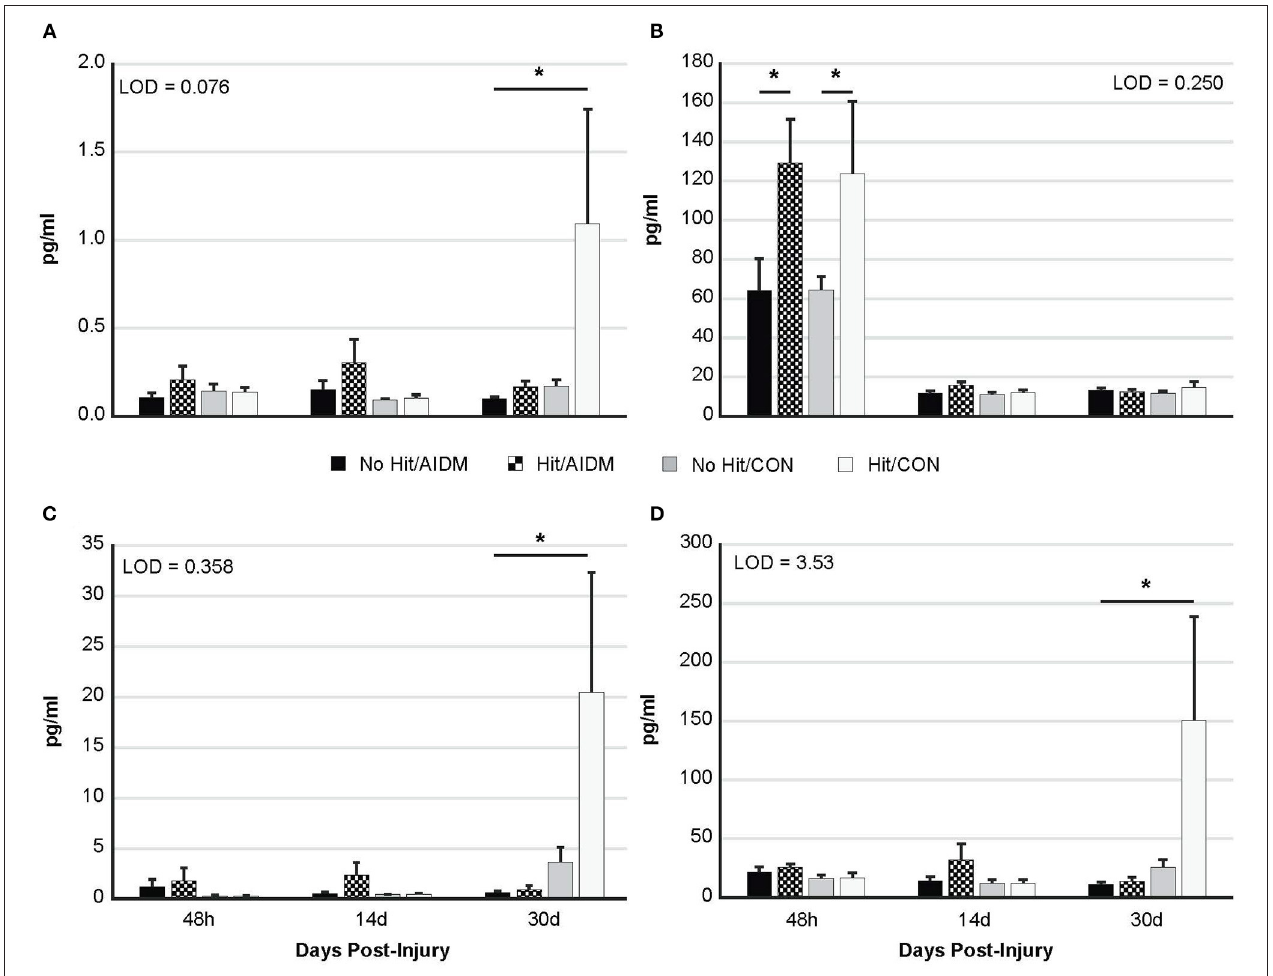
FIGURE 3 | Plasma levels (pg/ml) of four neurotrauma biomarkers at three end-points post-injury of 48h, 14 days, and 30 days. Rats consumed either anti-inflammatory (AIDM) or control (CON) diets for up to 30 days, and were divided into TBI-exposed (Hit) or non-TBI control (No Hit) groups. (A) T-tau, (B) NF-Light, (C) GFAP, and (D) UCH-L1. T-tau, total tau; NF-L, neurofilament-L; GFAP, Glial Fibrillary Acidic Protein; UCH-L1, Ubiquitin Carboxyl-terminal Hydrolase L1; LOD, Limit of Detection (pg/ml). *Groups that significantly differ from relevant non-injured groups, P < 0.005; Bar heights represent mean value ± SEM for n = 6 rats/group at 48h, and n = 12 rats/group at 14 and 30